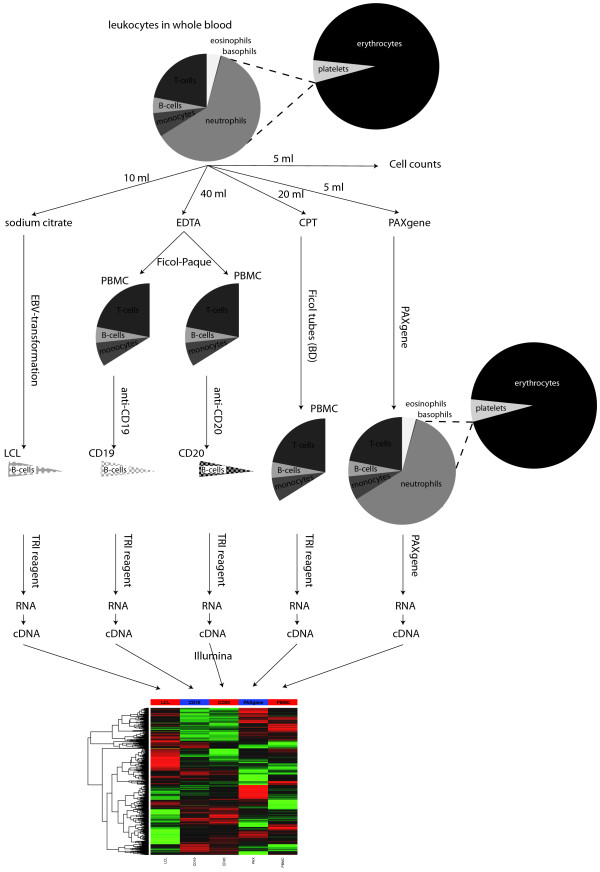
Study design. We obtained gene expression profiles of five different post venipuncture methods of cell and RNA isolation. The pie charts illustrate the different cellular composition of the five methods whereas the arrows show the laboratory processes.